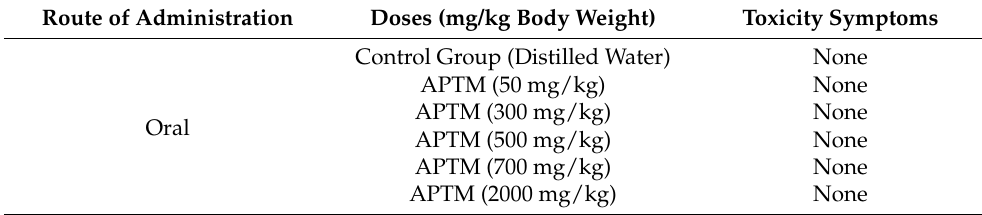
Table 1. Signs of acute toxicity of the aqueous extract of APTM.